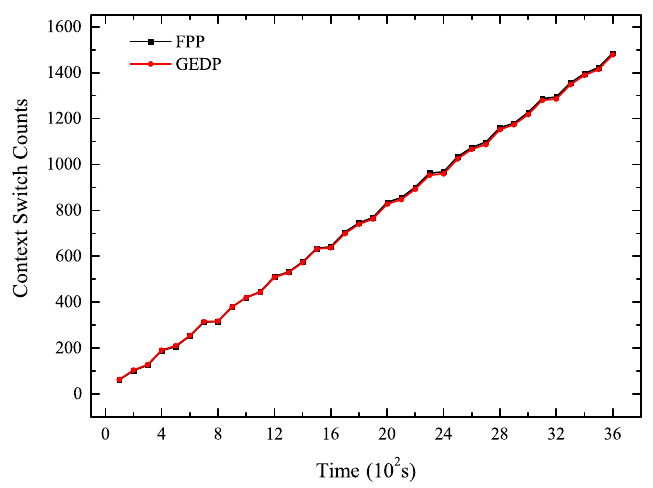
Figure 13. Involuntary context switches of